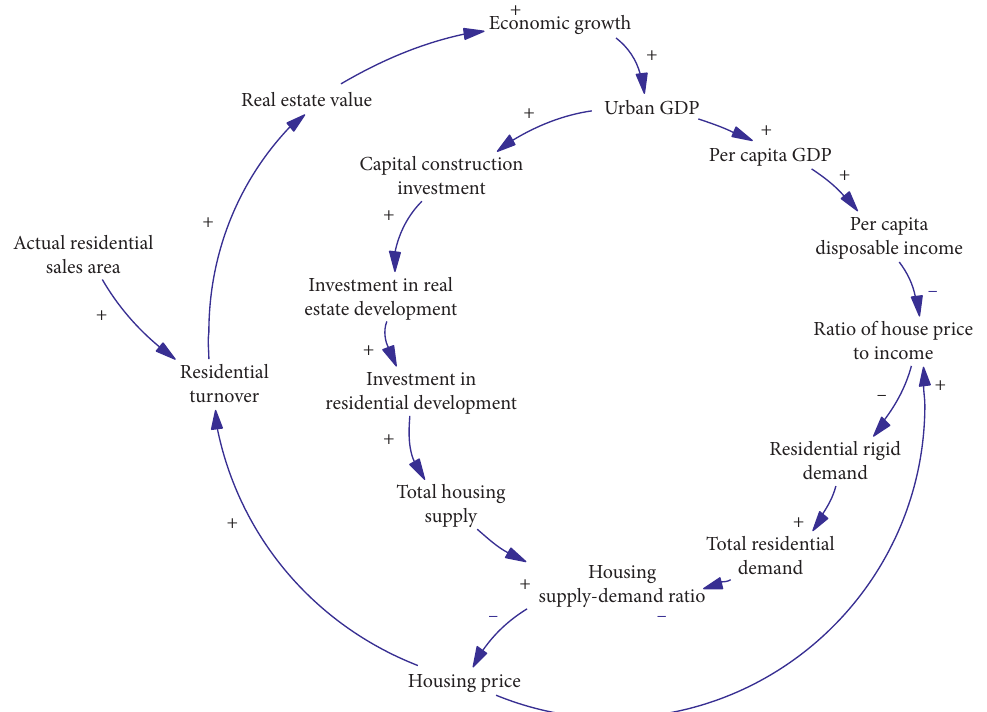
Figure 5: Causality diagram of urban economic